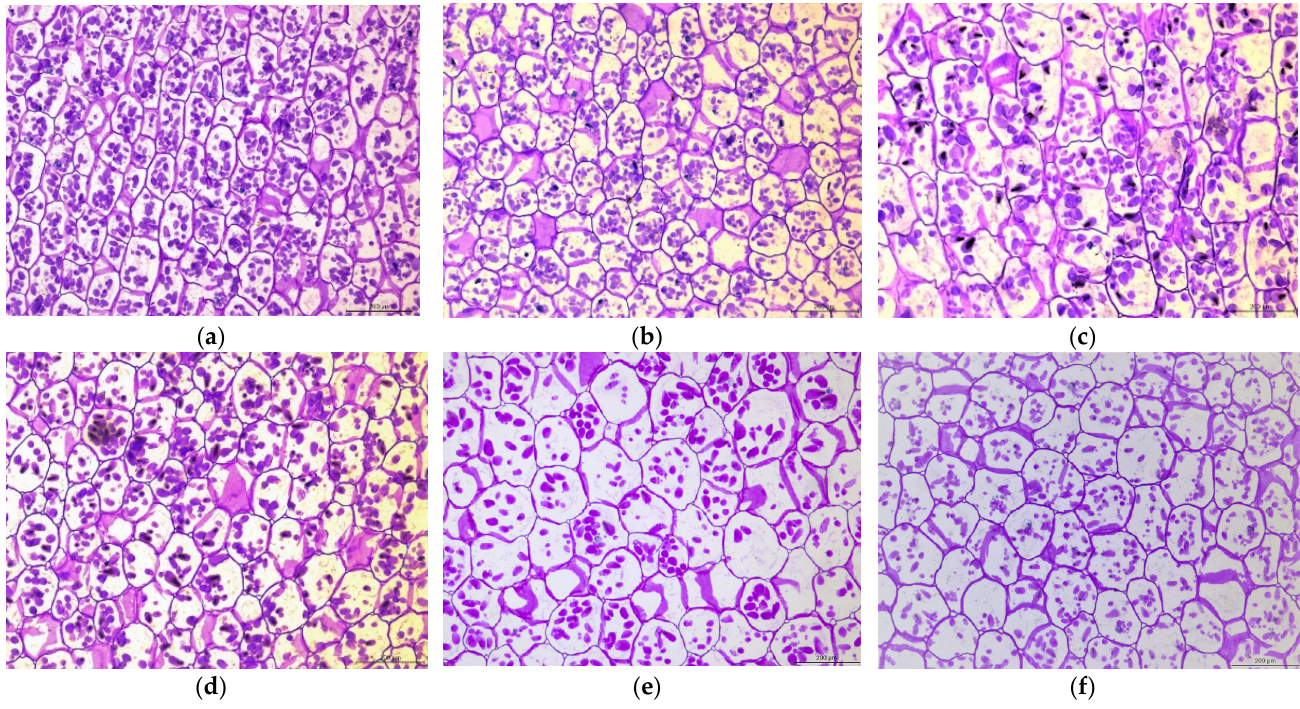
Figure 2. The changes of starch grains in middle scales of functional lily ‘Fly Tiancheng’ during cold storage. ( a ), ( b ), ( c ), ( d ), ( e ) and ( f ) represent bulb cells stored at 0 d, 15 d, 30 d, 45 d, 60 d and 90 d of cold storage, respectively. Starch granules are dyed purplish red and nuclei are dyed blue. At least five slices per period were used for observation, and each period showed one representative result.